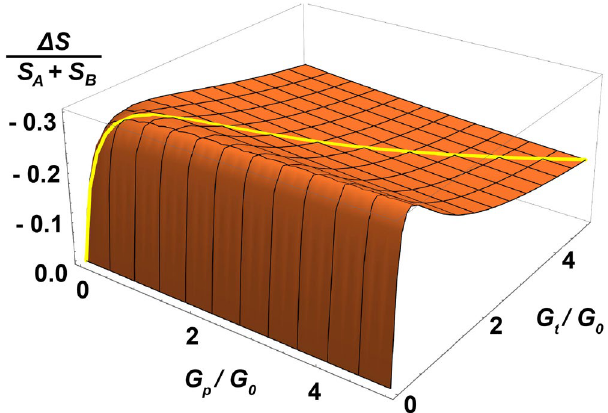
as a function of G G / and G G / . In our analysis we A B t 0 p 0